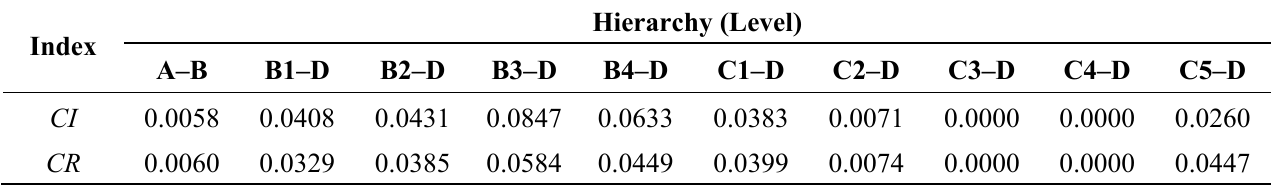
Table 2. Consistency index (CI) and consistency ratio (CR) within a